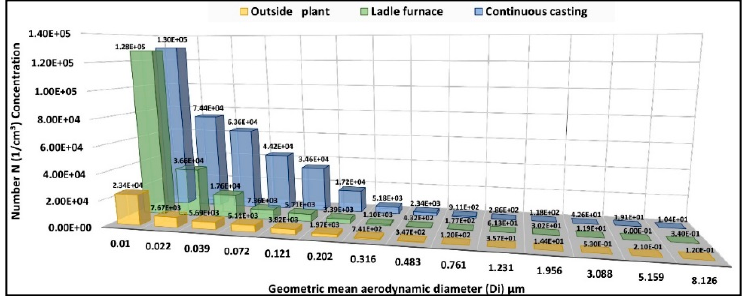
Figure 3. Mean values of the particle number concentrations (particles/cm 3 ) in 14 fractions (reported as geometric mean aerodynamic diameter [Di µm]) measured by Electric Low-Pressure Impactor (ELPI).